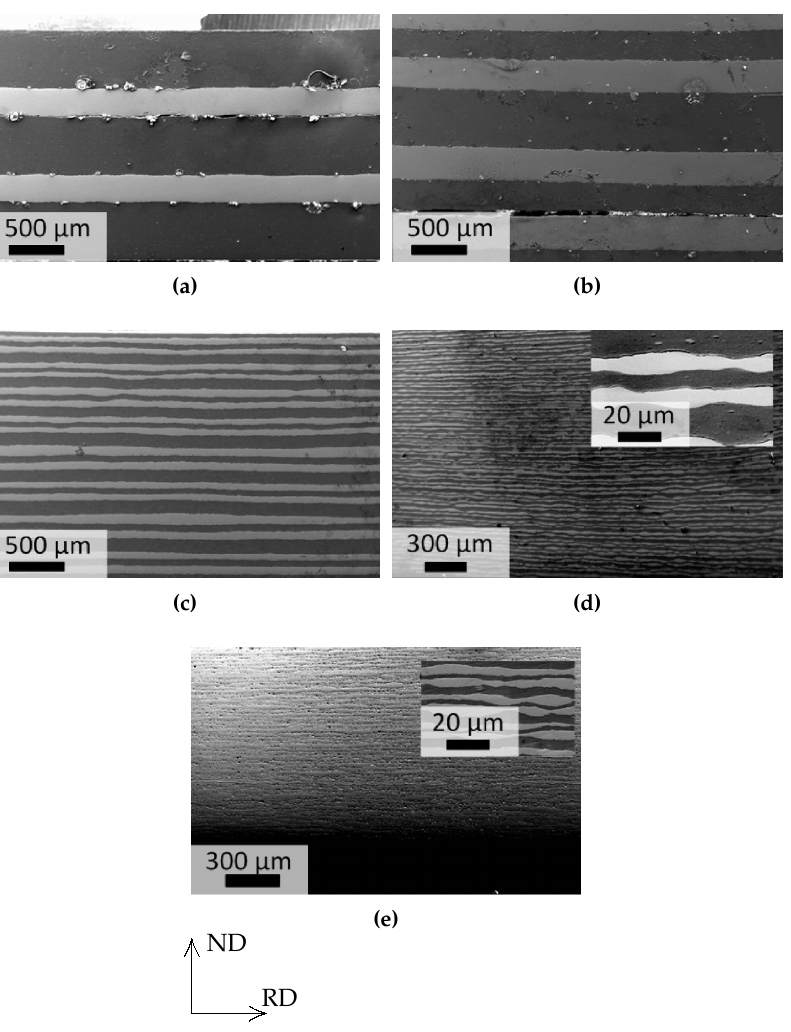
Figure 4. SEM micrographs showing the longitudinal cross-section of the layer structure of a Ti/Al composite sheets after accumulatively roll bonding a five-layered composite after the first ( a ), second ( b ); fourth ( c ), sixth ( d ) and eighth ( e ) ARB cycle with IHTs being